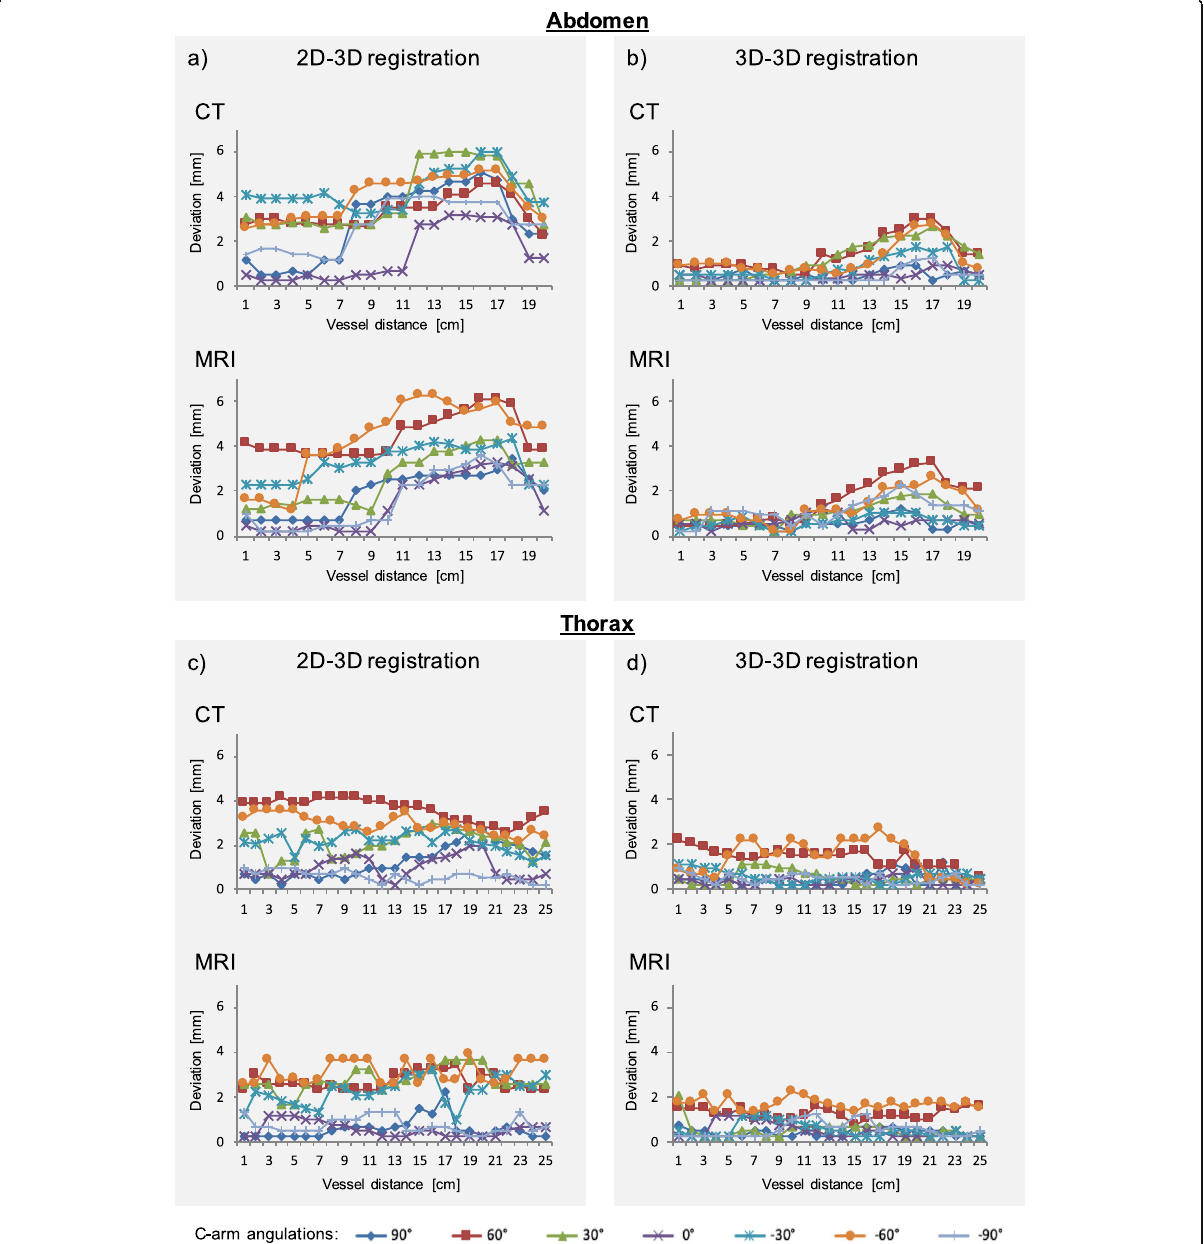
Fig. 4 Graphical illustration of the centerline deviation of the virtual 3D model compared to fluoroscopy images of the thoracic ( a , b ) and abdominal ( c , d ) aortas. For each anatomical region, centerline deviations along the vessel course are given for both registration techniques (2D- 3D; 3D-3D) and imaging modalities (CT; MRI), respectively. Each colored graph represents a c-arm angulation. The deviations between the centerlines were assessed along the vessel ’ s course every 10 mm. The measurements were performed in the thoracic aorta (from the aortic bulb to the diaphragm) and in the abdominal aorta (from the diaphragm to the aortic